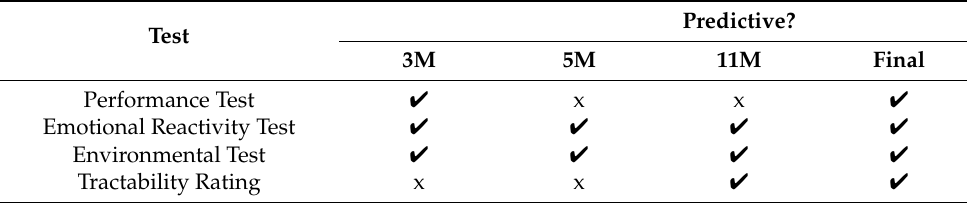
Table 2. Summary of results from the binary logistic regressions determining predictive validity of final outcome (selected/rejected) at each time